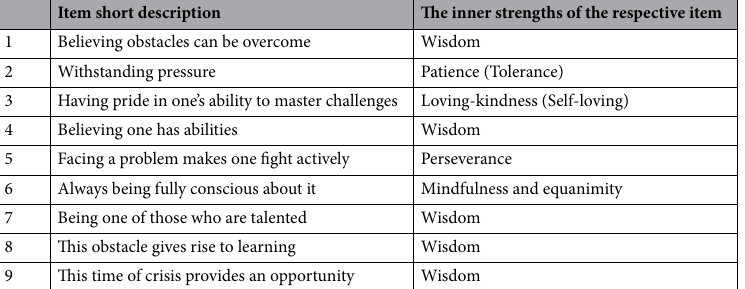
Table 1. The content of the 9-item resilience inventory and its based